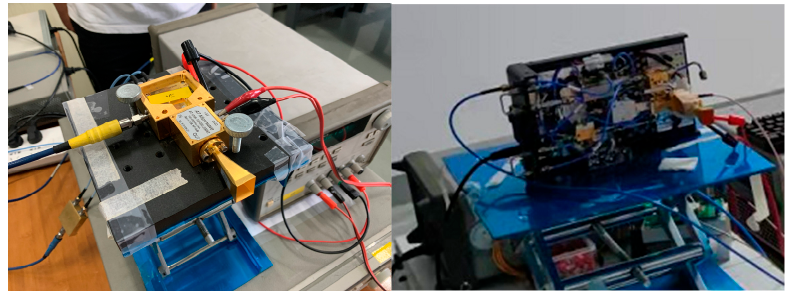
Figure 5. The photos of the experimental setup at the transmitter and receiver.